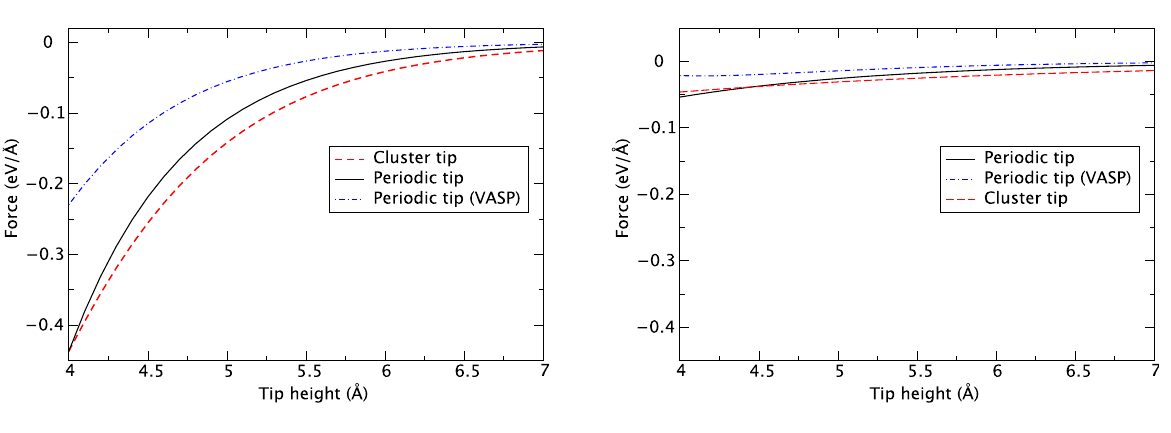
Figure 6: Tip force as a function of height directly above Cl − (left) and Na + (right) ions in the NaCl(001) surface, for the cluster tip and periodic tip, and an identical periodic tip but with energies determined from plane-wave (VASP) calculations [7].